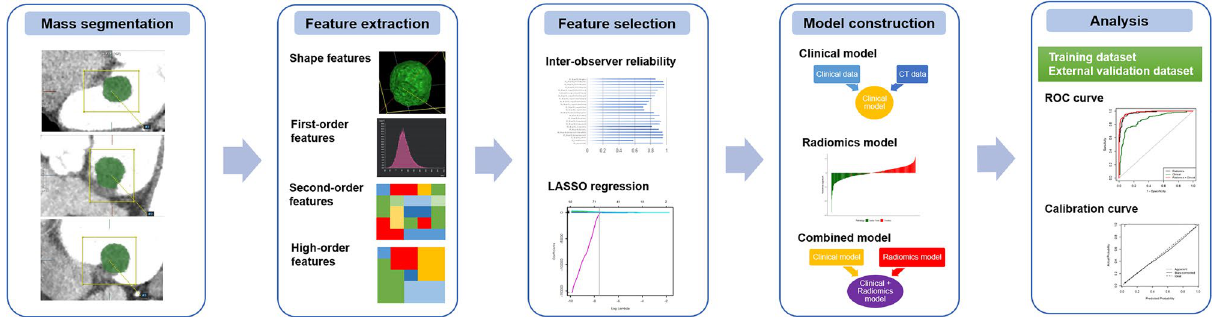
Figure 2. Flowchart showing the process of radiomics analysis. LASSO least absolute shrinkage and selection operator; ROC receiver operating